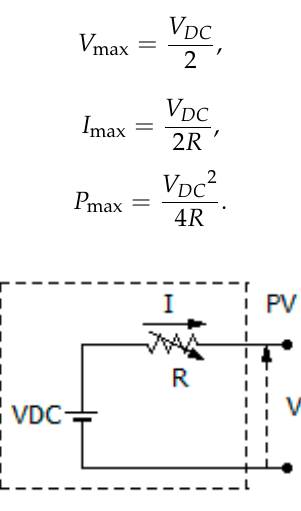
Figure 9. Electrical model for PV panel.